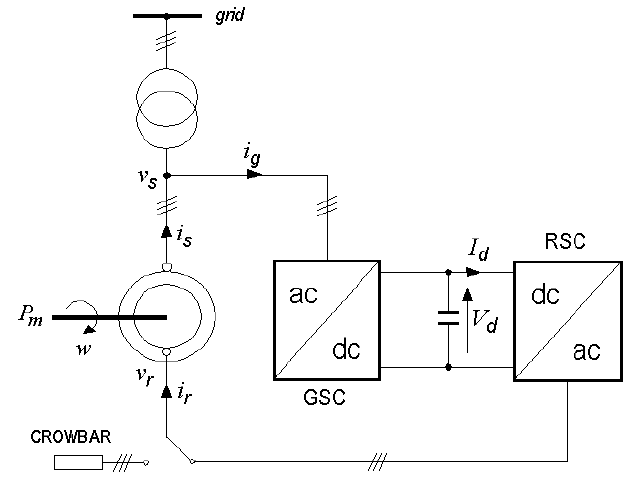
Figure 4. Doubly fed induction generator and crowbar